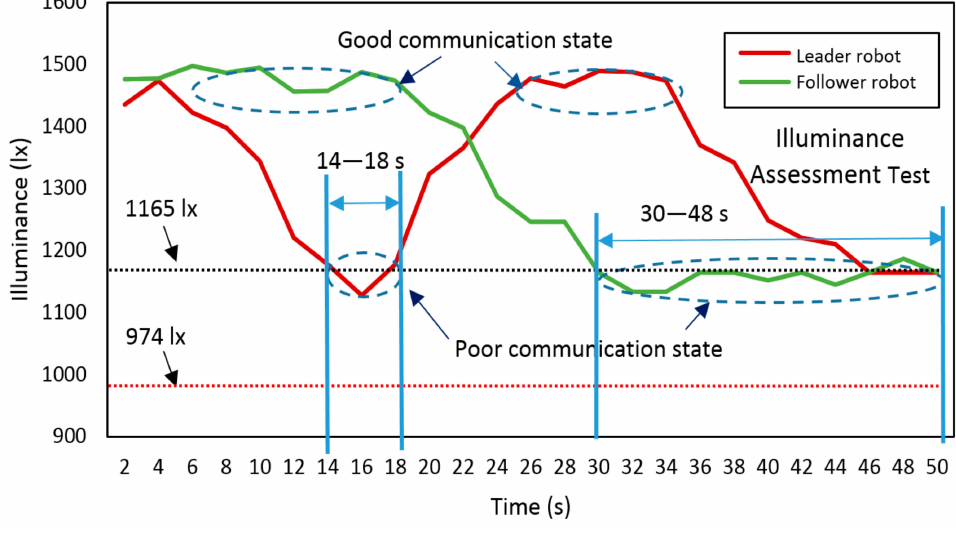
Figure 18. Comprehensive illuminance assessment test of RCS in pipe with steel